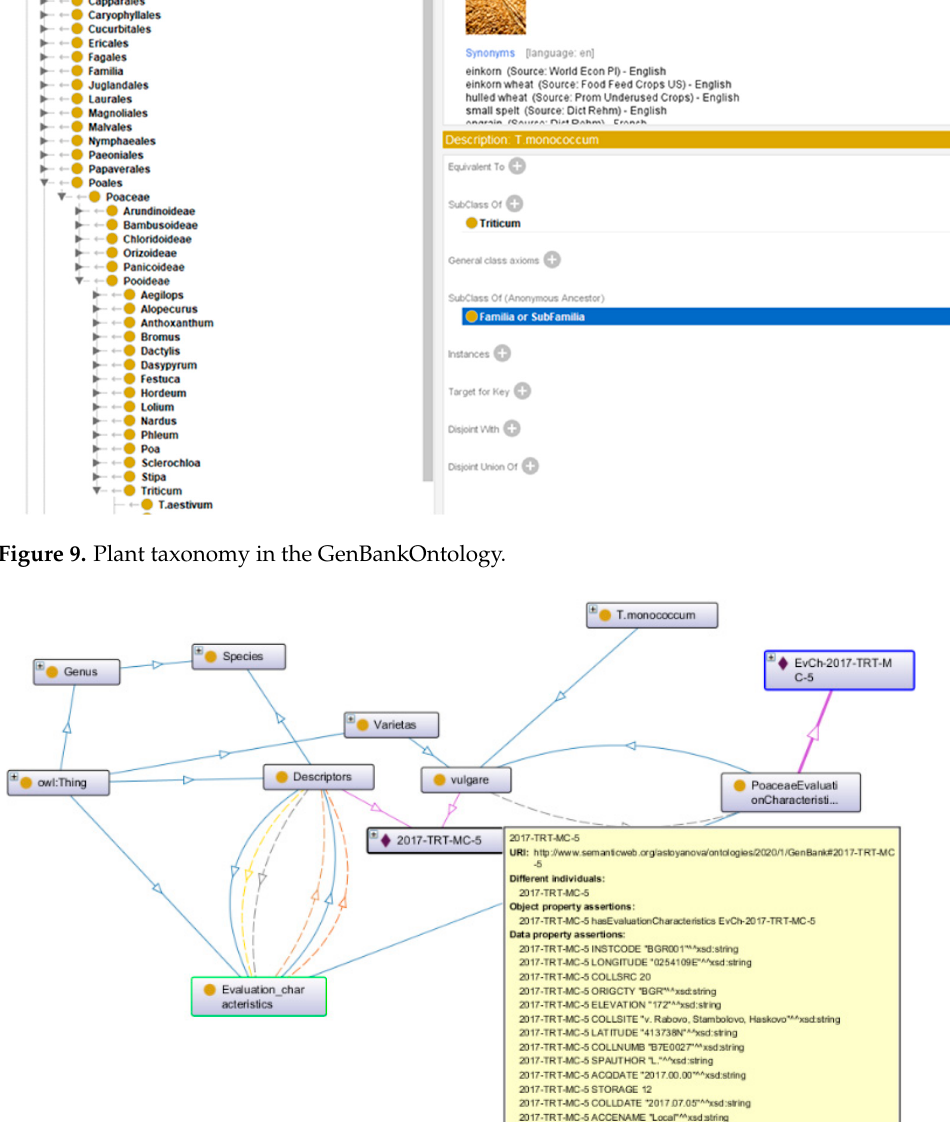
Figure 11. Evaluation characteristics of EvCh-2017-TRT-MC-5.